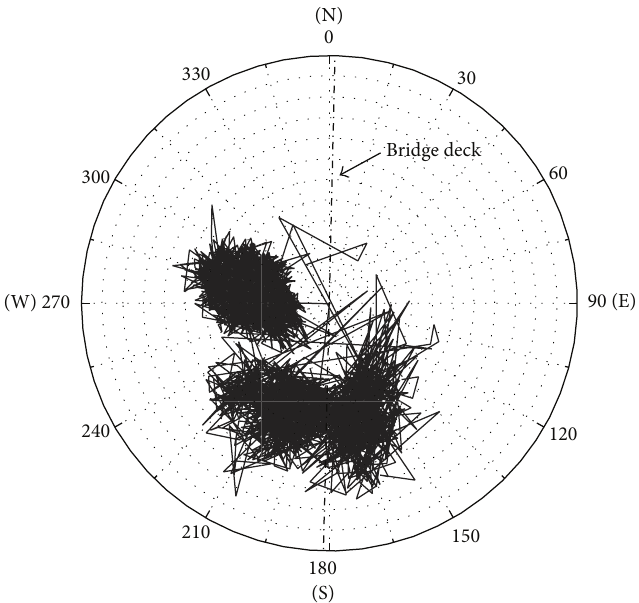
Figure 12: The wind direction variation during the observation period.